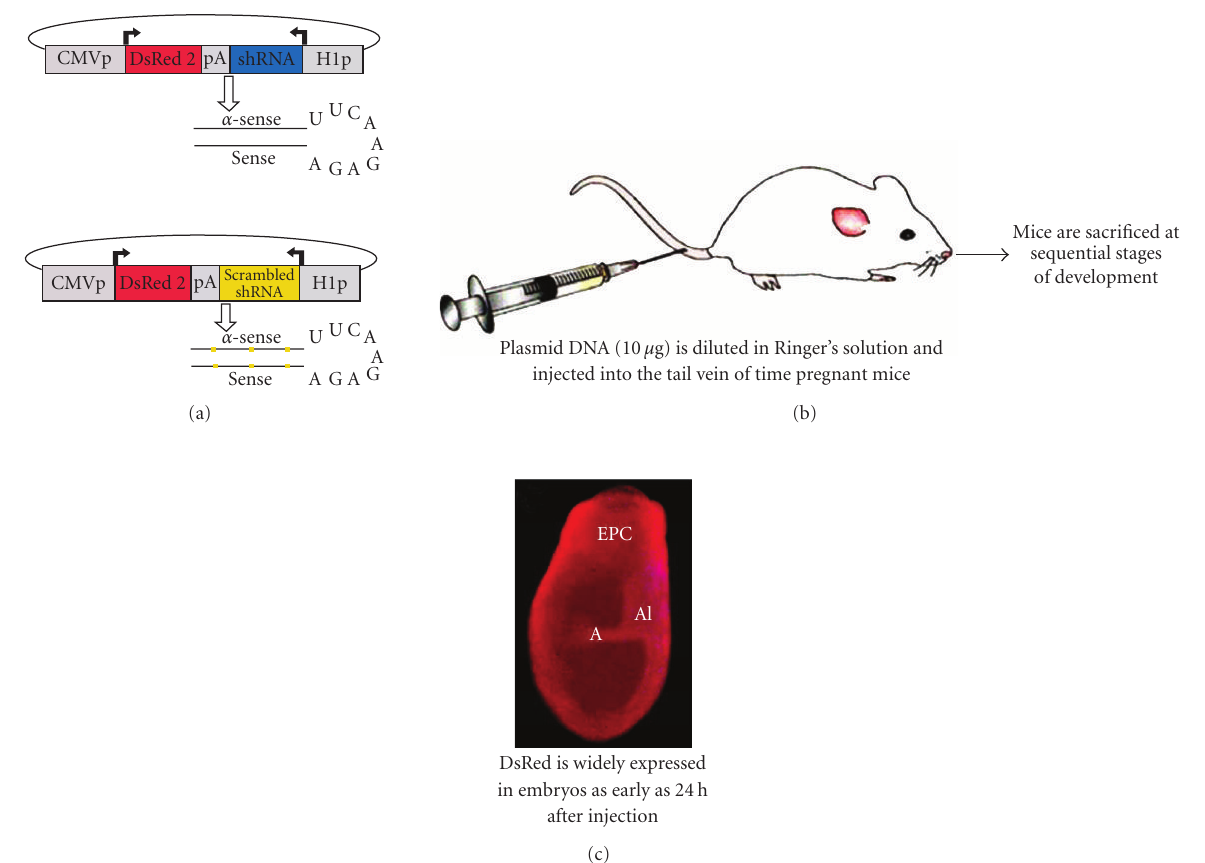
Figure 1: (a) shRNA expression plasmids were constructed using the pCS2 plasmid as the backbone. The DsRed 2.1 coding region was removed from the pDsRed2-1 vector (Clontech) and cloned downstream of the CMV promoter in the MCSI. The mouse H1 promoter (1040–1215 nt) of the RNAseP/PARP2 promoter, GenBank accession AF191547, was PCR-amplified from genomic DNA and cloned into MCSII. Gene-specific shRNAs (blue region) or scrambled shRNAs (yellow) are then ligated downstream of the H1 promoter. (b) Tail vein injections were carried out in pregnant mice as we have done previously (29). (c) Embryos are dissected from the uterus, and decidua and membranes are removed. Transmitted light and fluorescence images of embryos are captured using a Leitz-inverted fluorescence microscope to determine the extent of DsRed expression and to examine their morphology. A: amnion, Al: allantois, EPC: ectoplacental cone.